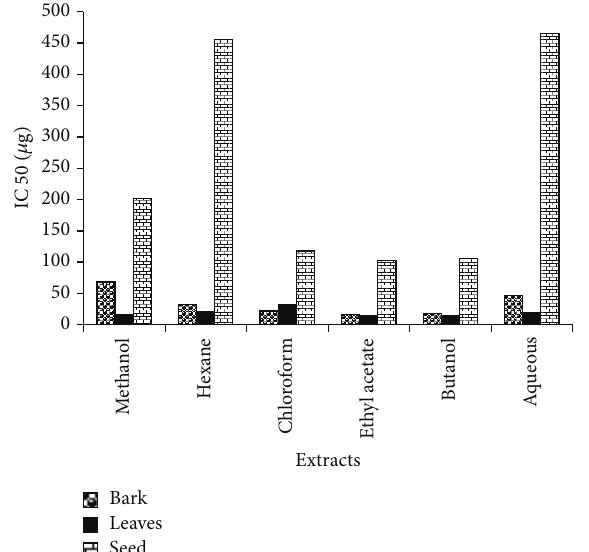
Figure 3: FRAP of different extracts of L. pulverulentus .